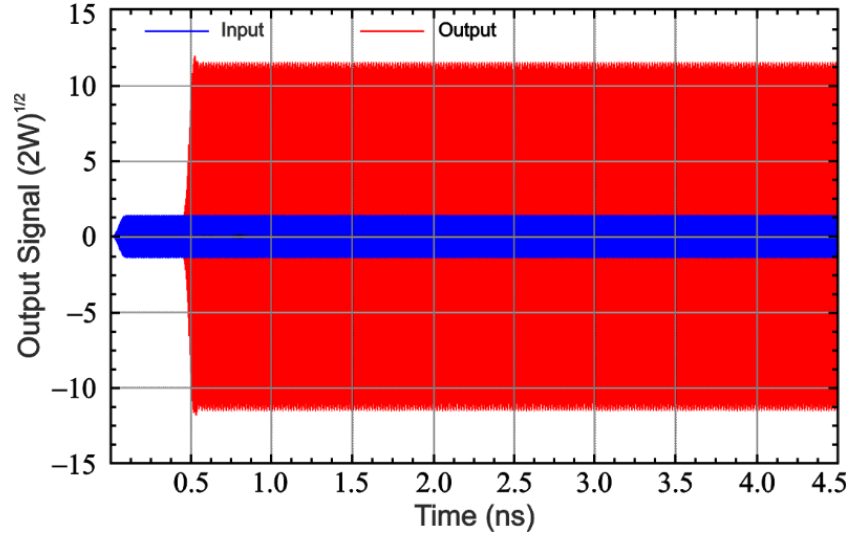
Figure 7. Input and output signal waveforms at 220 GHz frequency and 1 W input power.